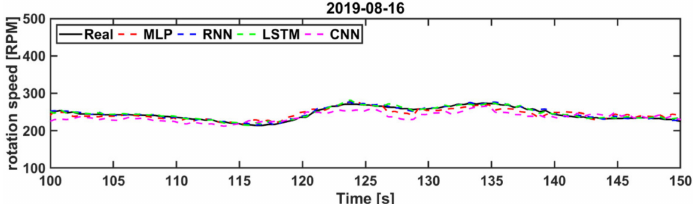
Figure 21. Detailed comparison of the prediction performances of each algorithm for the conditions of Case 6 (training datasets: 26 April 2019, 20 July 2019, 16 August 2019; test dataset: 16 August